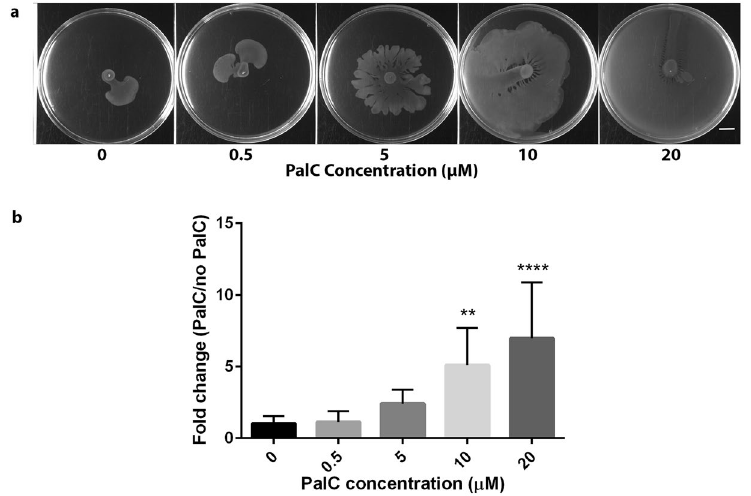
Figure 3. PalC increases swarming motility of S . Typhimurium. ( a ) S . Typhimurium motility was assayed on swarming plates with increasing concentrations of PalC. The images are representative of one of three technical replicates from one of three biological replicates. ( b ) Fold change in percentage of agar plate covered by swarming area, comparing PalC added at various concentrations to an untreated PalC negative control. Bars: SD (n = 9, three separate experiments, with three technical replicates per experiment); two asterisks ( ** ) indicates significant difference compared to untreated control, P ≤ 0.01; four asterisks ( **** ) indicates significant difference compared to untreated control, P ≤